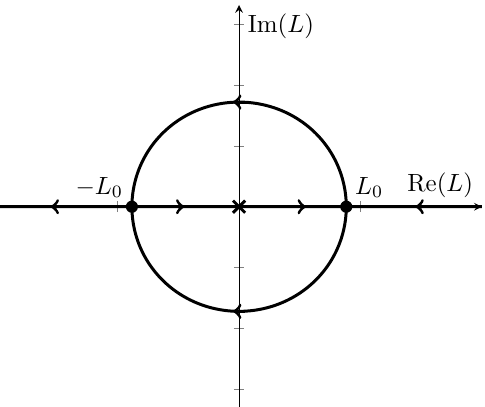
Figure 1 . Steepest descent contours for the evaluation of the integral of ( r; L ). The thick lines denote values for which ( r; L ) is real; here we have set r = 1, but the qualitative behaviour is independent of r . Direction of the arrows denotes the direction in which the integrand is